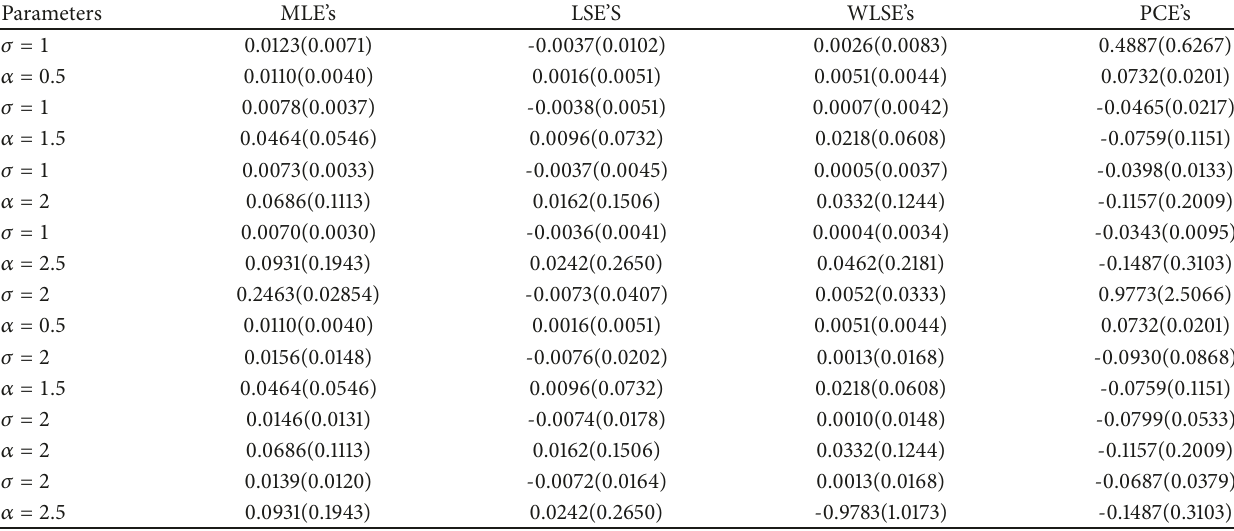
Table 4: Average bias values of estimates and their MSE (in brackets) when